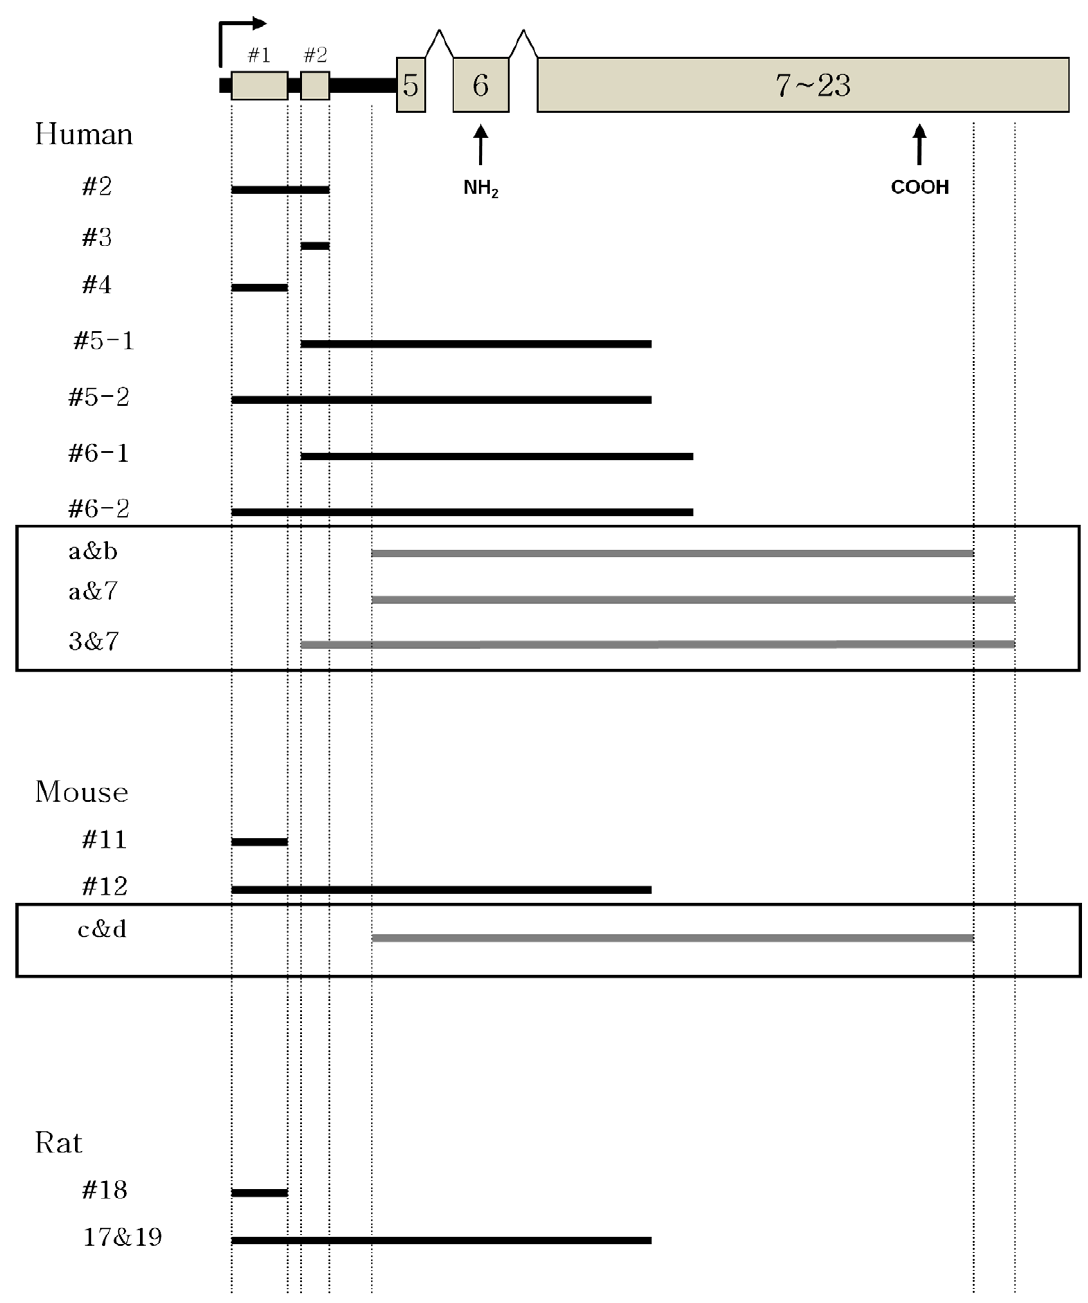
Figure 3. Strategy for cloning GABAB1k. The top figure represents exon-intron composition of the proposed GABAB1k. Numbered rectangular boxes represent known exons, and lines between boxes are introns. Two arrows on the bottom of the boxes represent ORF. Black bar is intron 4, and the two probe sequence data, NCBI accession numbers W07715 and N80593, are indicated as # 1 and # 2 above small rectangular boxes, respectively. They are 5 9 and 3 9 sequences of the microarray probe, clone 300899. A arrow above the black bar is a possible transcription initiation site. Horizontal lines indicate sequences detected after PCR. Based on microarray probe, clone 300899, the following clones were detected in human cultured cells, mouse midbrain, and rat hippocampus: # 2, # 3, # 4, # 11, and # 18. From the previous microarray probe sequence analysis, the microarray probe aligned to intron 4 and was either 3 9 or 5 9 UTR of novel isoforms. Because there was no known human GABAB1 isoform that had intron 4 as an exon, the two possible isoform models, GABAB1j and GABAB1k, were proposed. The predicted GABAB1j and GAGAG1k contain intron 4 as 3 9 or 5 9 UTR, respectively. Because GABAB1j and GABAB1k are only two possible isoform models that contain clone 300899, # 2, # 3, # 4, # 11, and # 18 can be partial GABAB1j or GABAB1k and show their existences. From the same RNA sources six different N-terminal partial clones, # 5-1, # 5-2, # 6-1, # 6-2, # 12, and 17&19, indicated the existence of GABAB1k. They share common 5 9 UTRs and partial N-terminal ORFs of GABAB1k and suggest that GABAB1k exists in human, mouse, and rat. To clone the full ORF of GABAB1k, additional primers were designed at its possible 3 9 UTR region based on other known isoform sequence analyses. Full ORF containing clones were cloned from human brain and mouse midbrain. Bottom two boxes show clones which contain the full ORF (a&b, a&7, 3&7 in human and c&d in mouse).